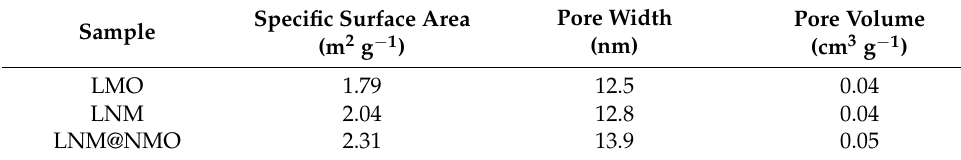
Table 2. BET parameters of the LMO, LNM and LNM@NMO spinel samples.